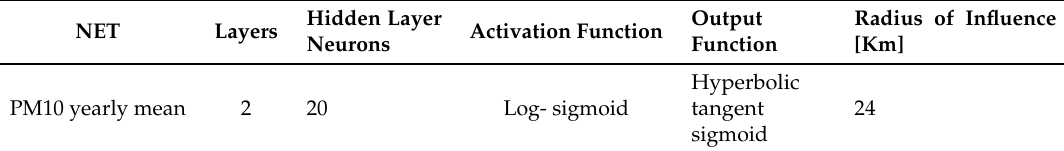
Table 1. Architecture of the Artificial Neural Network applied to reproduce yearly PM 10